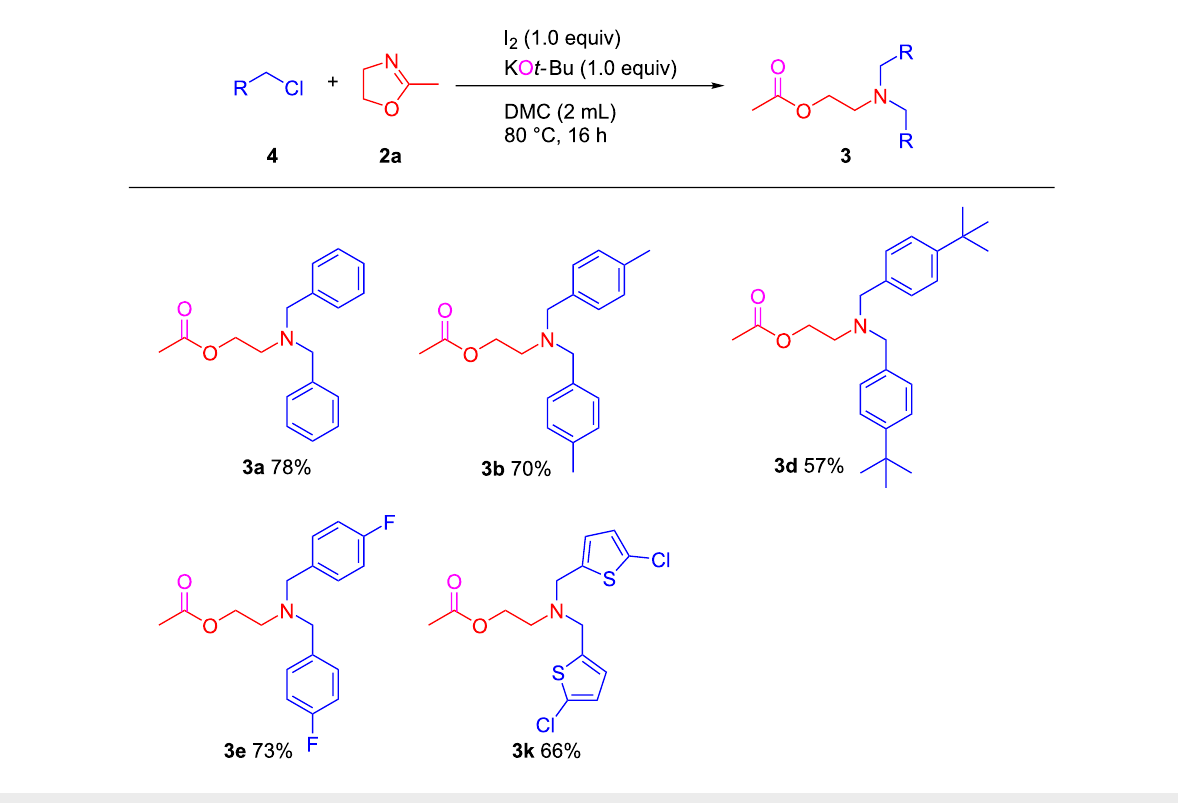
Scheme 3: KO t -Bu-promoted selective ring-opening N -alkylation of 2-methyl-2-oxazoline with benzyl chlorides. Conditions: KO t -Bu (0.5 mmol), 2-methyl-2-oxazoline (0.5 mmol), benzyl chlorides (1.0 mmol), I 2 (0.5 mmol) in DMC (2 mL), at 80 °C, under air for 16 h.